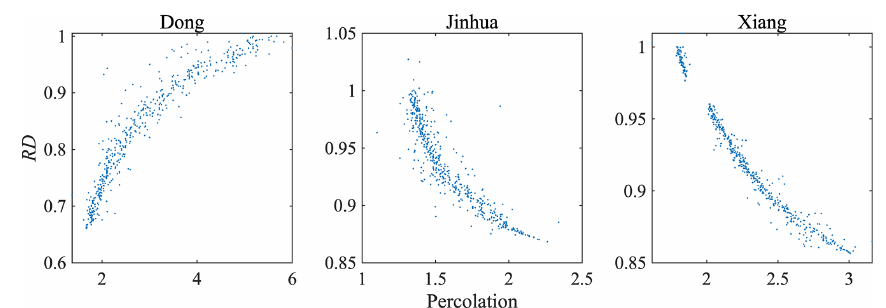
Figure 11. Relationship between percolation and RD in the three cases.